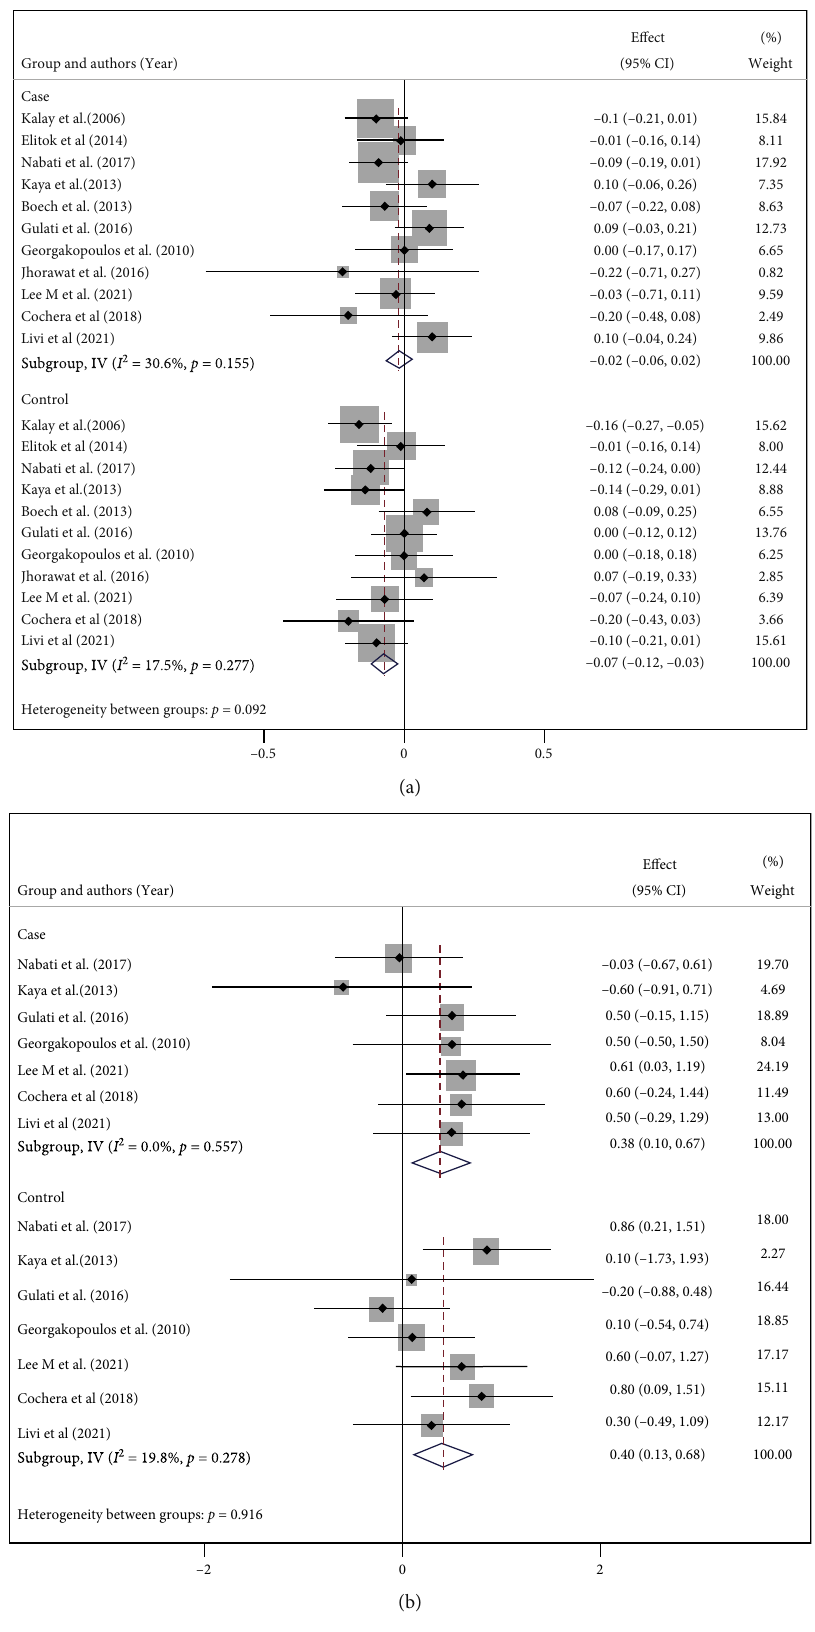
Figure 4: Forestplot of two group changes from the baseline of (a) E/A ratio and (b) E/e ’ ratio as an indices for diastolic